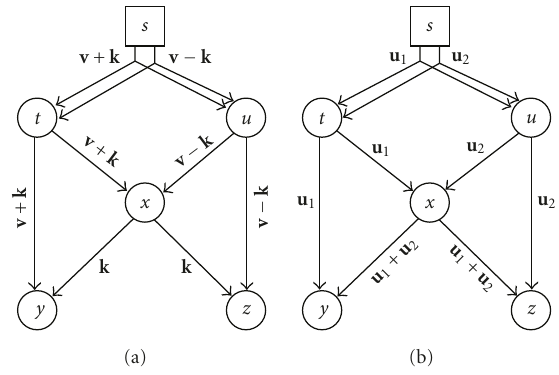
Figure 2: (a) The source node s sends v to sink nodes y and z . For security Cai et al. add an independent random packet k to v . (b) At source node s we transform the packets ( v 1 , v 2 ) into ( u 1 , u 2 ) by a lin- ear ANOT T S then send the pseudopackets u 1 and u 2 to sink